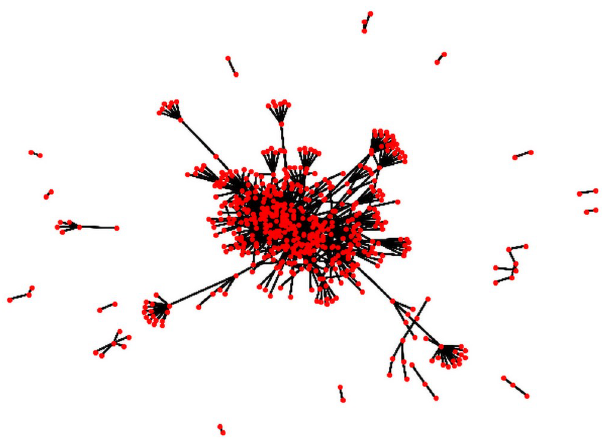
Fig 4. Example education network of an anonymous municipality. The red dots represent nodes and the black lines represent edges.